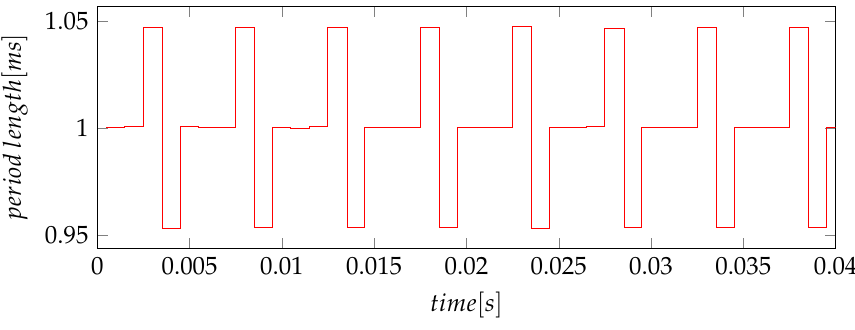
Figure 13. Periodicity of Gyroscope jitter.